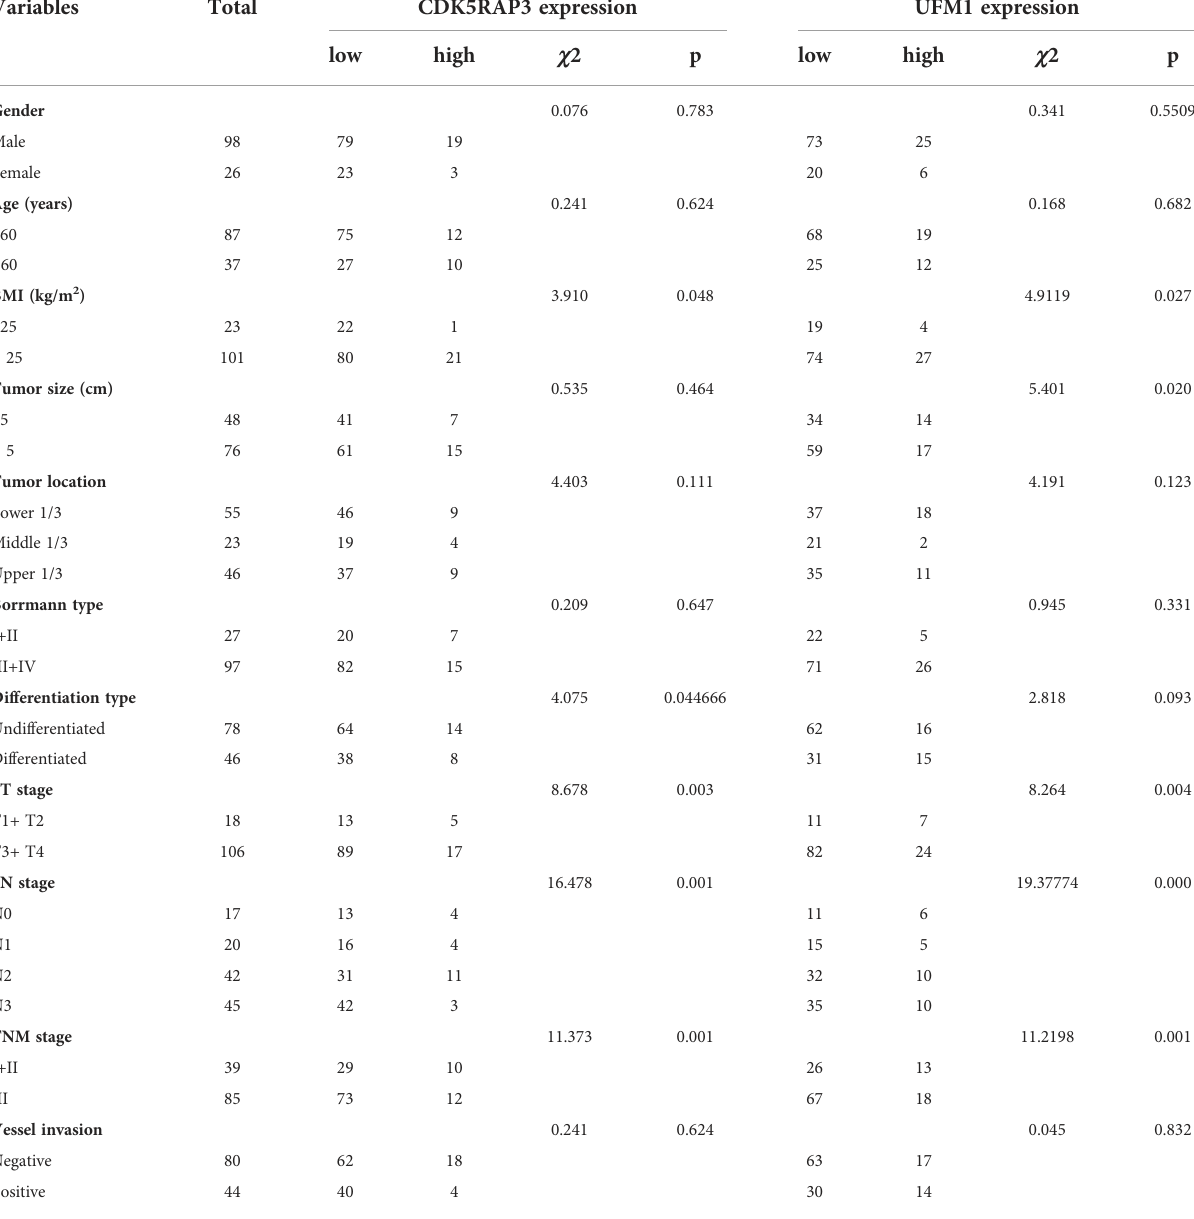
TABLE 1 The association of CDK5RAP3 and UFM1 expression in gastric cancer tissues with clinicopathological factors.